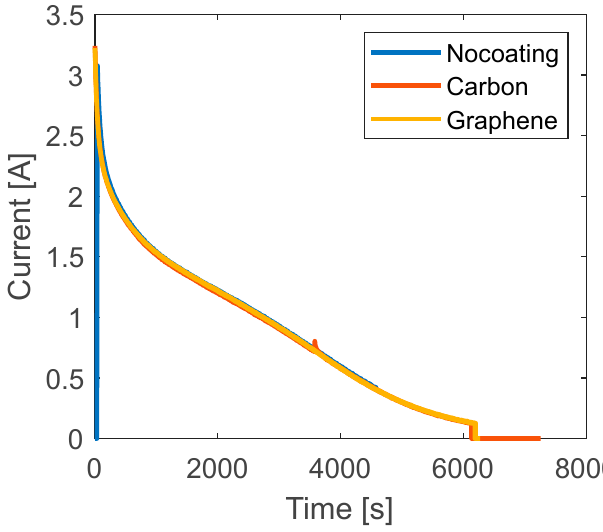
12 of 20 Figure 7. Curves of temperature versus time for different coatings for discharge tests at 0.5C. Table 4. NRMSE between the curve of temperature for the uncoated and coated battery at discharge